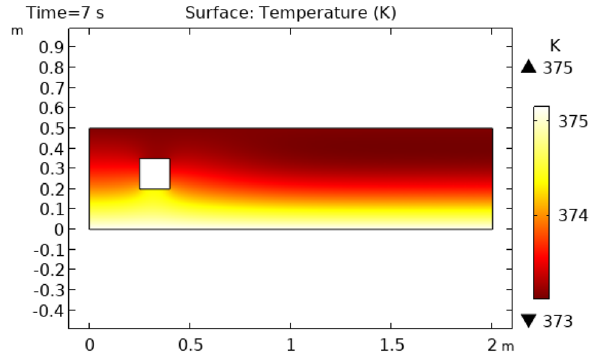
Figure 12. Surface Temperature in squared cylindrical flow at t = 7 s.